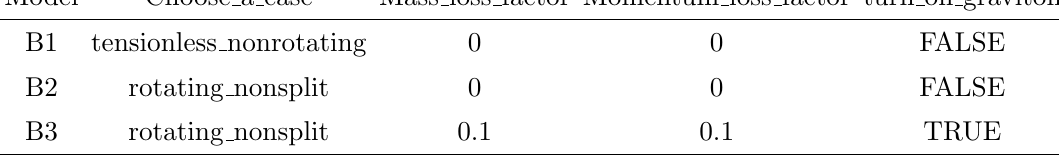
Table 1 . Generator settings used for BlackMax signal sample generation.